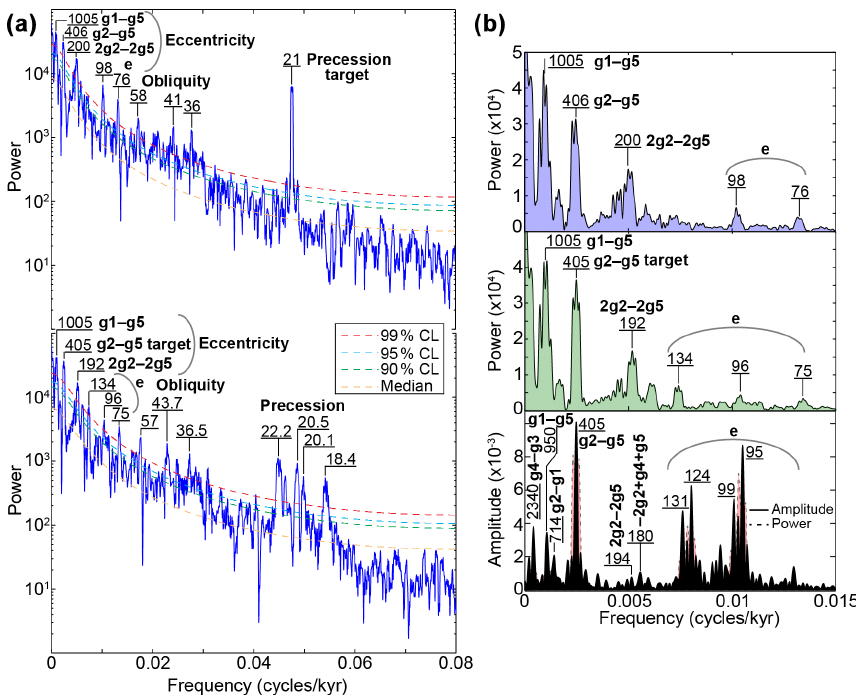
Figure 7. 2 π -MTM power spectra of the entire tuned raw NGR data. (a) Upper spectrum of the 21kyr precession (Fig. S7c) tuned NGR, (lower) spectrum of the 405kyr tuned NGR. (b) Upper and middle spectra are the same as in (a) but for the interval 0–0.015cycles/kyr and in a linear-scale power axis, to highlight the low-frequency portion of the spectra. Lower spectrum of La2004 eccentricity over the equivalent time interval (31.110–38.501Ma). Secular frequency for each eccentricity component is given, except for the short eccentricity ( e ), which has several components (e.g., Laskar et al., 2004). Table 1. Durations of Chrons C12r through C16n.1n inferred from CDB1 core cyclostratigraphy and in comparison with previous timescales. Geomagnetic Polarity Time Scales: CK95 (Cande and Kent, 1995), GPTS2004 (Ogg and Smith, 2004) and GPTS2012 (Vandenberghe et al., 2012), Astronomical Time Scale (ATS): HP2006 from ODP Site 1218 (Pälike et al., 2006), TW2014 from ODP PEAT sites (Pacific Equatorial Age Transect, Exp. 320) (Westerhold et al., 2014). Magnetostratigraphic and radioisotopic dating: WRG and UMB are White River Group and Umbria–Marche Basin respectively (Sahy et al., 2020). Note that durations of all these chrons in GTS2020 (Gradstein et al., 2020) are from Westerhold et al. (2014) and subsequently used in Westerhold et al. (2020). Polarity chron CK95 GPTS2004 HP2006 GPTS2012 TW2014 WRG CDB1 core (this